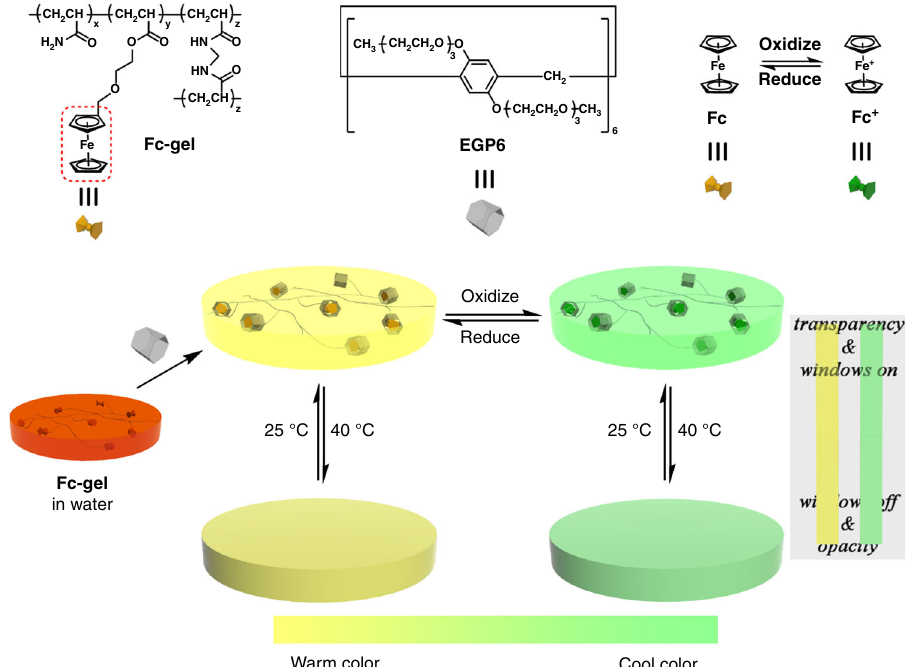
Fig. 1 Chemical structures and schematic illustration of the warm/cool tone switchable thermochromic material for smart windows. Preparation of Fc-gel ∙ EGP6 hydrogel and the schematic illustration of warm/cool tone switchable thermochromic material based on the orthogonal integration strategy of the unique properties of pillar[6]arene and